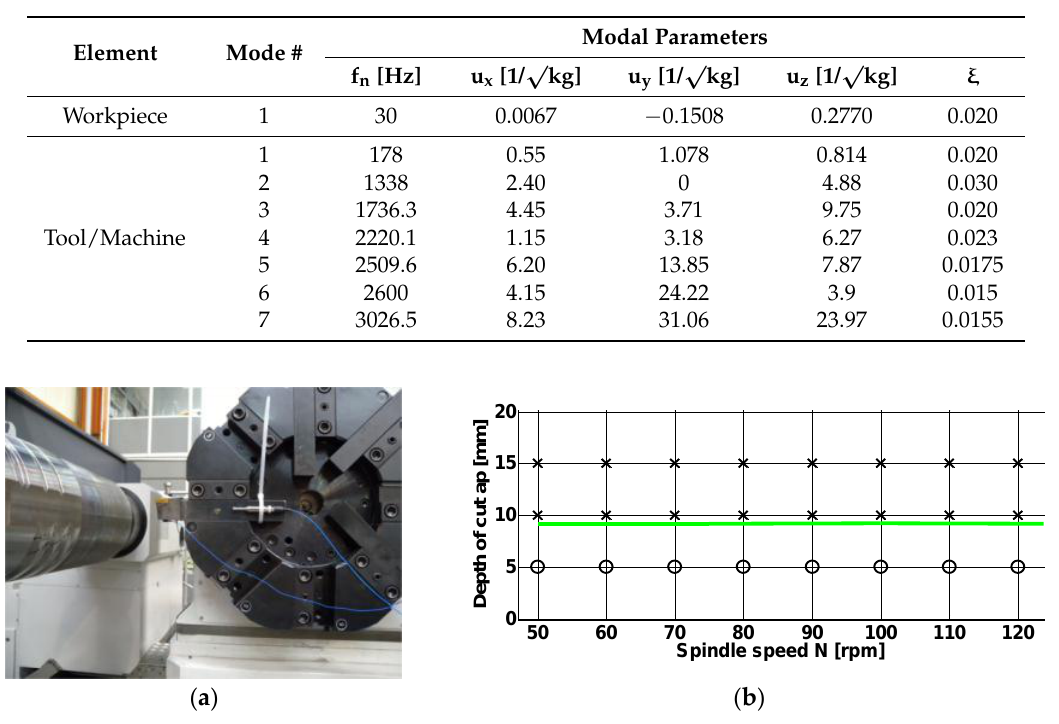
Figure 13. ( a ) Sound acceleration recording; ( b ) Stability lobes versus experimental points.